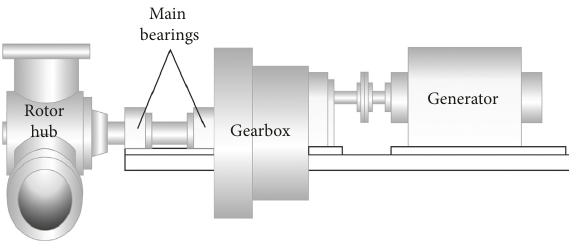
Figure 1: Drive train of a wind